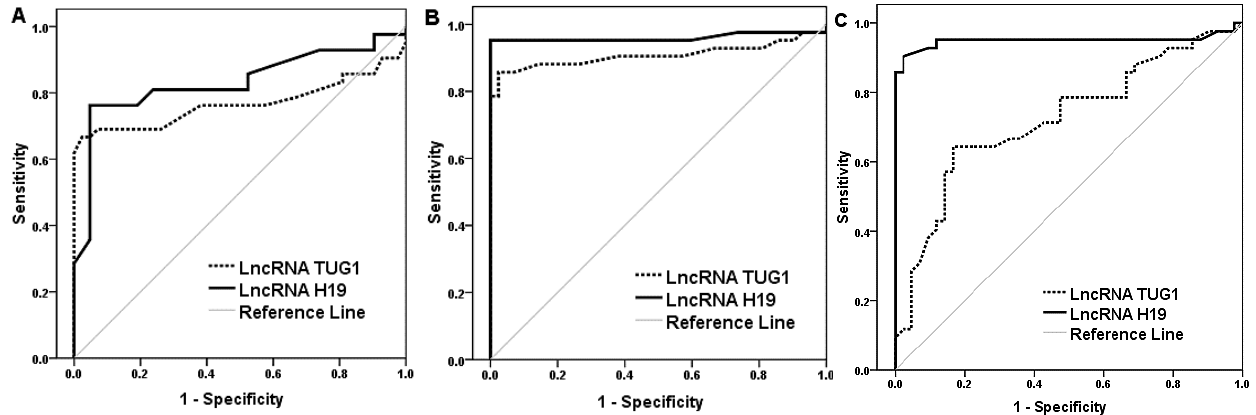
Figure 2. ROC curve for lncRNA expression. ( A ) Differentiation between healthy controls and diabetes, ( B ) differentiation between healthy controls and IBS diabetic patients, ( C ) differentiation between diabetic patients and diabetic patients with IBS. Table 2. The diagnostic performance characteristics of the studied markers.